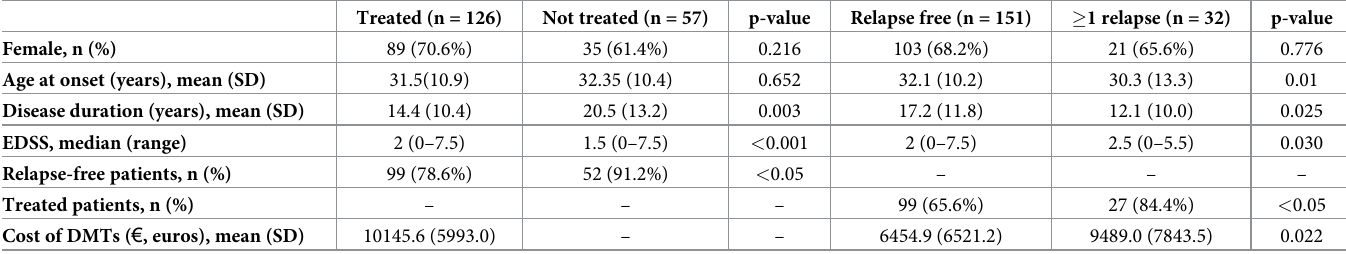
Table 2. The number of DMTs did not correspond to the number of treated patients since 13 patients used two different DMTs in 2019. One hundred and fifty-one patients (82.5% of the cohort, 95% CI: 77%–88%) remained relapse-free during 2019. One hundred and seventy-one patients did not show an increase in their EDSS (93.4%) in 2019. A total of 144 patients (78.7%) underwent MRI in 2019; 126 of these (87.5%) had no new T2 lesions or gadolinium- enhancing lesions; the proportion of patients with NEDA-3 in these 144 patients was 69.4%. The disease characteristics and cost of treatment in the different patient groups of the 2019 cohort are shown in Table 4. Table 4. Disease characteristics of the 2019 cohort and cost of the